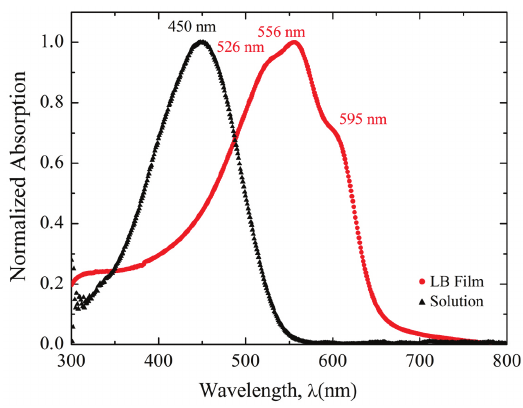
Figure 3. UV–vis absorption spectra of P3OT/54SA solution and LB film (11 layers).